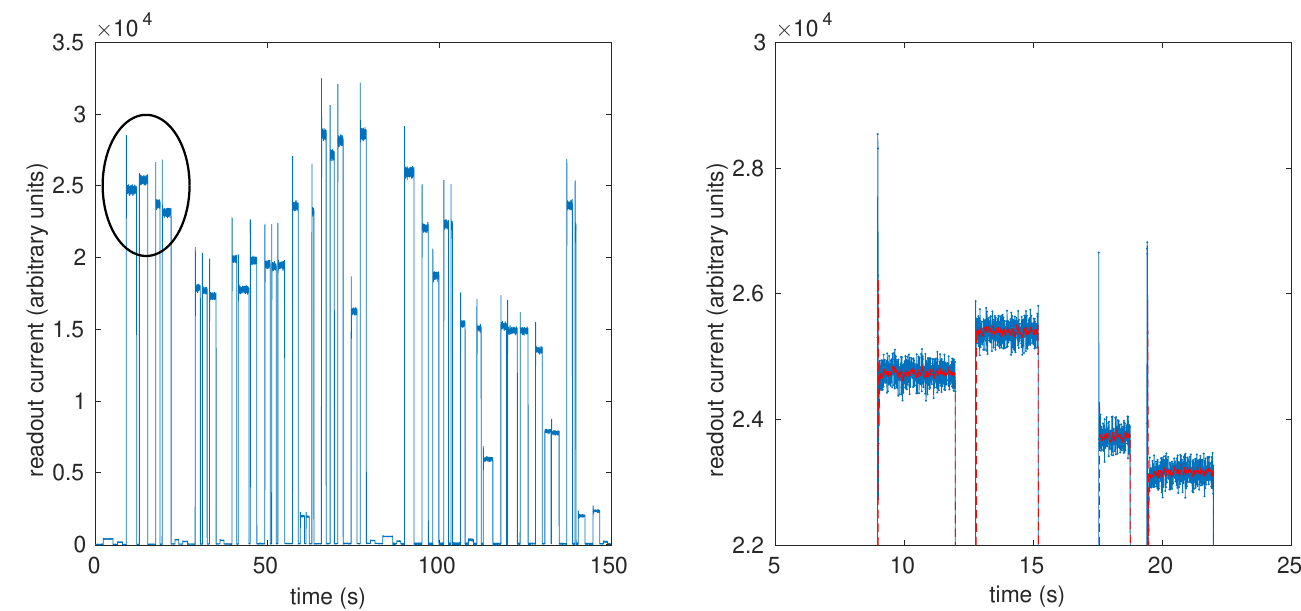
Figure 1. Ionization current in a pixel of a liquid-filled ionization chamber during the verification of a clinical radiotherapy treatment delivered at 600 MU/min. The many segments composing the treatment are easily spotted in the ( left ) panel. The ( right ) panel shows a zoom-in of the region highlighted within the ellipse shown in the ( left ) panel, and illustrates the effect of the moving average procedure (Equation (16) with n = 10): moving average (red line), raw data (blue